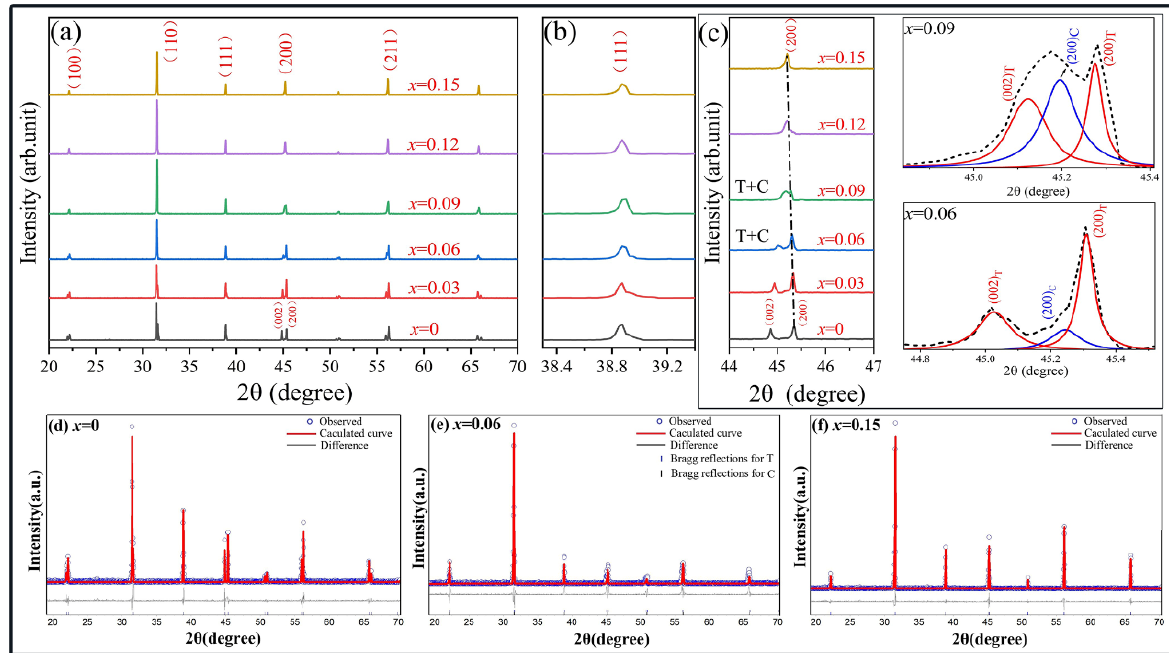
Figure 3. XRD patterns of ( a ) the as-sintered (1 − x )BT- x CSZ ceramics with different compositions, ( b ) the amplified patterns at 2 θ = 38.4º~39.2º , ( c ) the enlarged XRD patterns of the (200)/(002) peaks and the peak fitting in x = 0.06 and 0.09, ( d – f ) Rietveld refinement results of the (1 − x )BT -x CSZ ceramics with x = 0, x = 0.06 and x = 0.15 at room temperature.